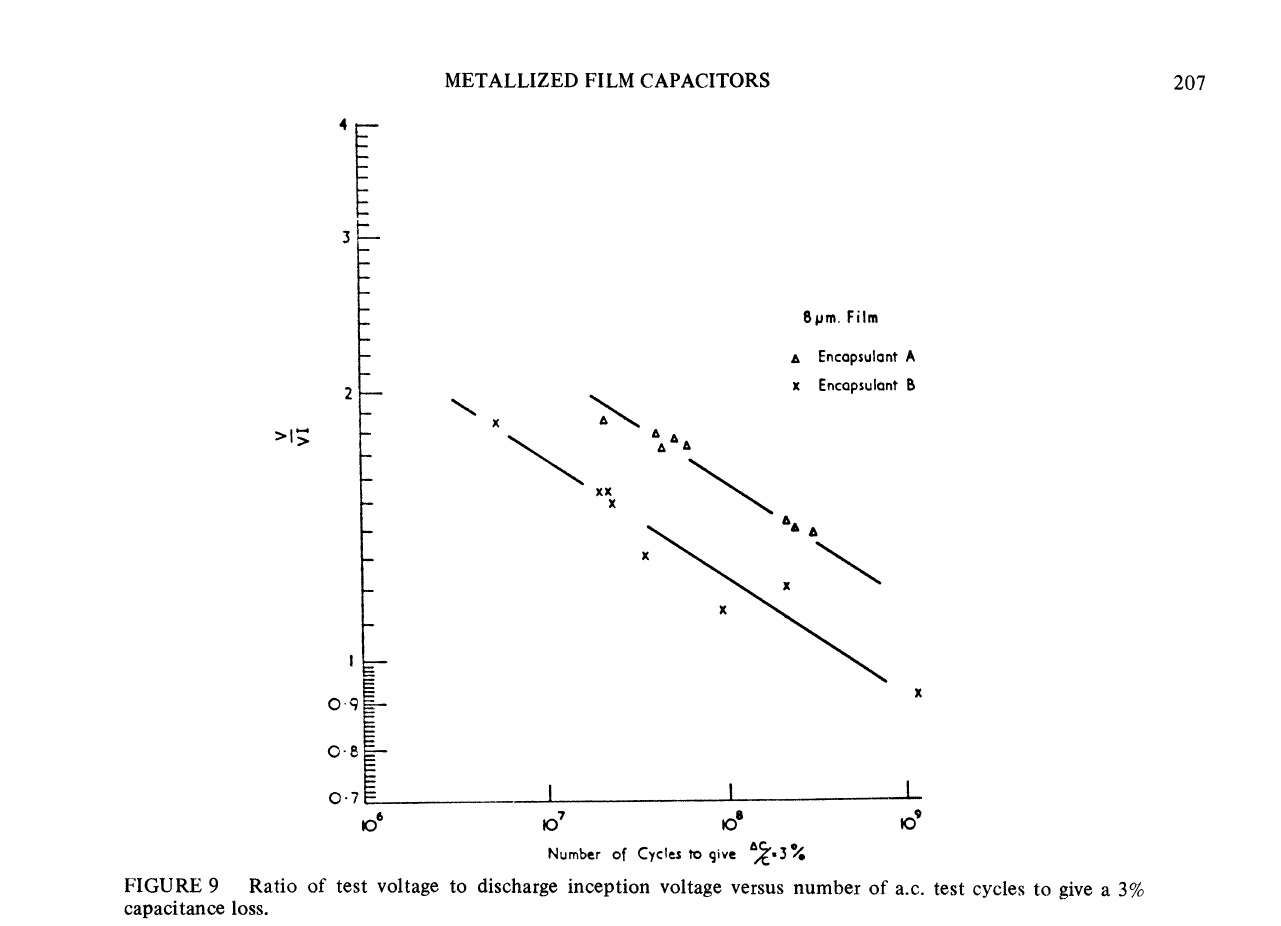
FIGURE 9 Ratio of test voltage to discharge inception voltage versus number of a.c. test cycles to give a 3% capacitance loss. form discharge channels which eventually propagate aging of bulk plastic materials by discharges in gas filled cavities within the plastic. Observed rates of deterioration for life-tested capacitors under various ambient conditions conform with predicted rates, so establishing structural damage from discharges as a primary contributor to capacitor deterioration and